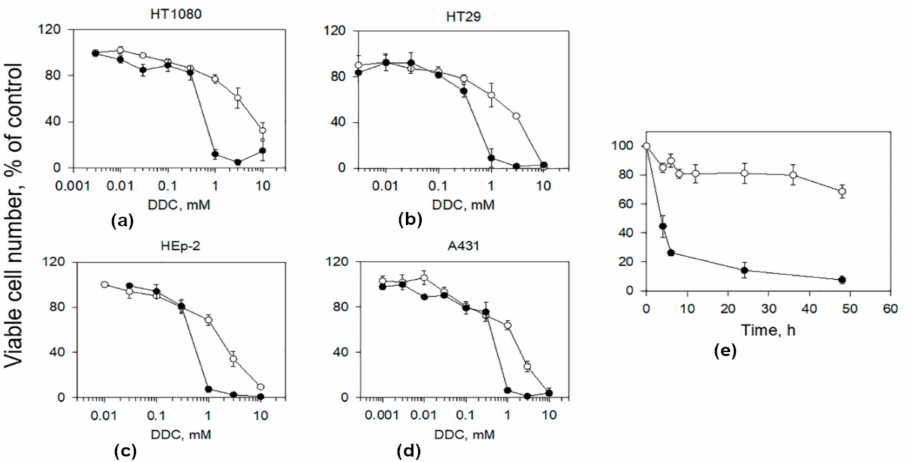
Figure 1. Vitamin B 12b enhances the cytotoxic e ff ect of DDC in subconfluent cultures of tumor cells. ( a – d ) Enhancement of the cytotoxic e ff ect of DDC by 25 µ M B 12b toward HT1080, HT29, HEp-2, and A431 cells. ( e ) Dependence of the cytotoxic e ff ect of the combination 1 mM DDC + 25 µ M B 12b against subconfluent cultures of HEp-2 cells on the exposure time. The components (B 12b and DDC) were added simultaneously 24 h after cell seeding. The action of DDC + B 12b was interrupted by replacing the culture medium with a fresh growth medium. The cytotoxicity was estimated 48 h after the addition of DDC and B 12b (see Materials and methods). Incubation with 1 mM DDC (open circles) and with DDC + B 12b (filled circles). The data are the means ± s.e.m. of five separate